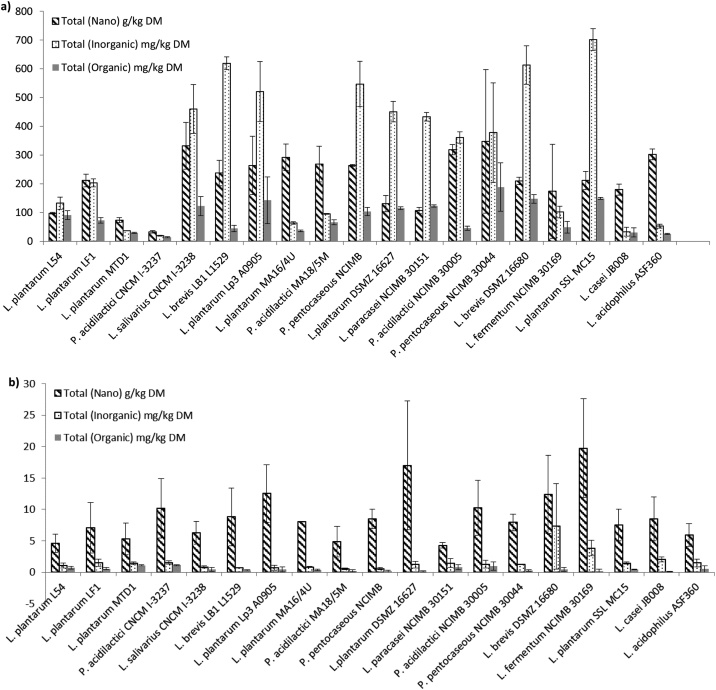
Se content of the isolates cultured in MRS broth with sodium selenite (SeMRS; a) and without (MRS; b). Means presented with standard error of the mean.